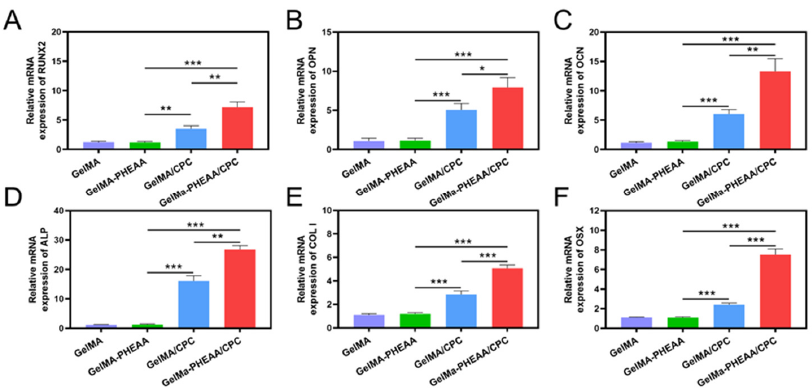
Figure 5. Expression of osteogenic-related genes in MC3T3 cells seeded on hydrogels at Day 7: ( A ) Runx2, ( B ) OPN, ( C ) OCN, ( D ) ALP, ( E ) COL I and ( F ) OSX, (n = 4, * p < 0.05, ** p < 0.01, *** p < 0.001).